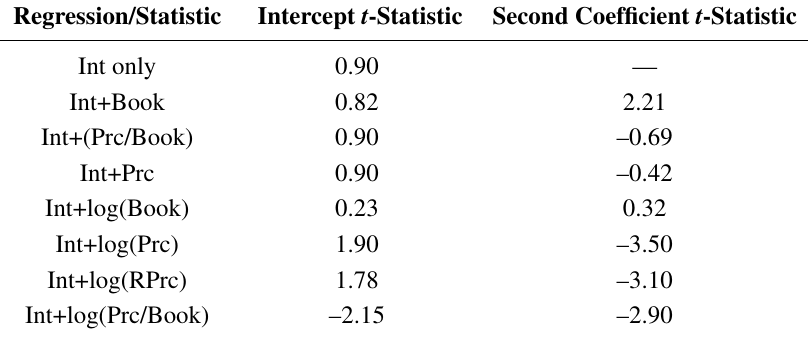
Table 5. Results for regressions (54) and (55) with the BICS-sector 10-factor model as the